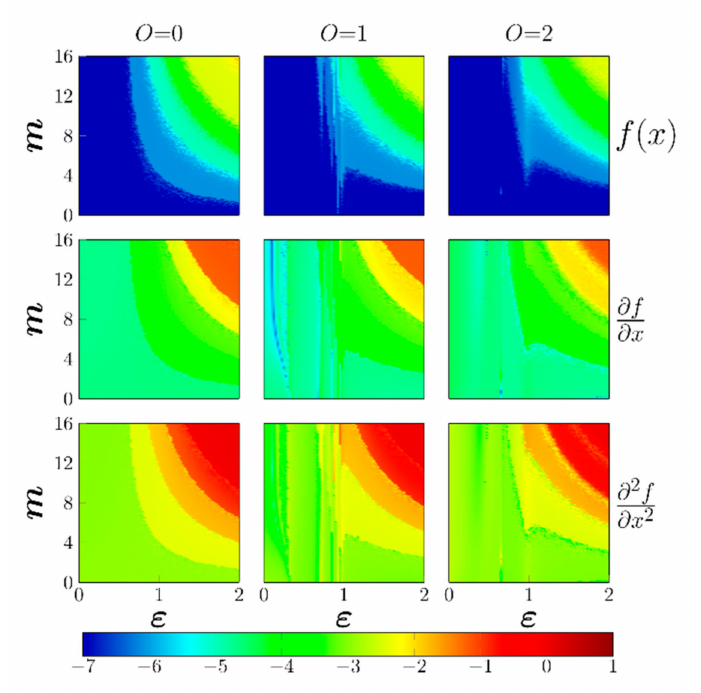
Figure 7. The log10 of the norm of the error of approximating the given function f ( x ) and its first two derivatives using Gaussian RBF-TPU with different truncation orders for a range of ε and m values. The rows are for function, first derivative, and second derivative approximation, while the columns are for the zeroth, first, and second orders of truncation. The ε k range is [0, 1] and N e =